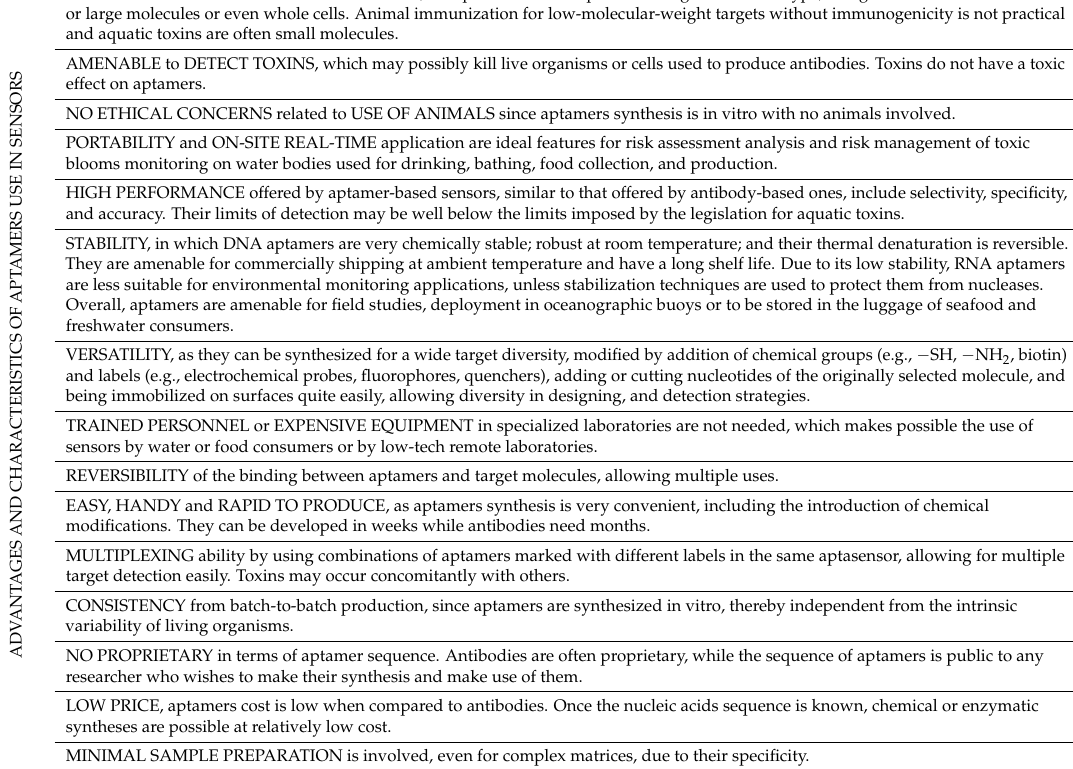
Table 1. Description of the advantages of the use of aptasensors relative to sensors that use other recognition elements, and of the main characteristics, which are specifically suitable for aquatic toxins